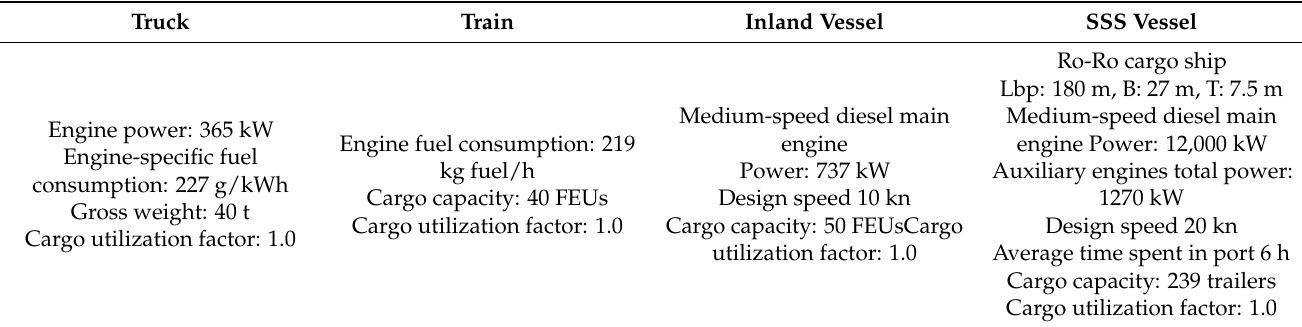
Table 10. Detailed technical characteristics of vehicles used in transport chains.